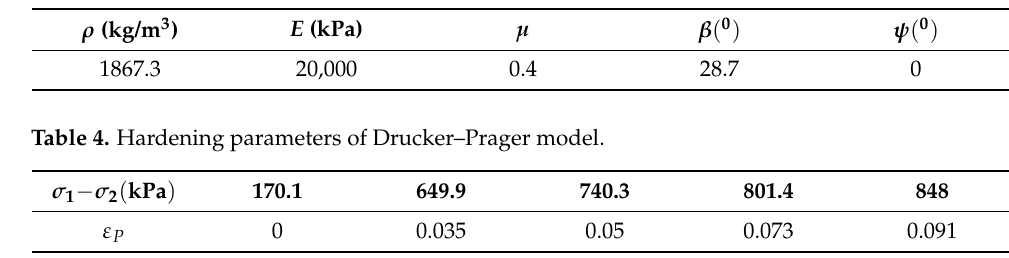
Table 3. Parameters of Drucker–Prager model for soil.